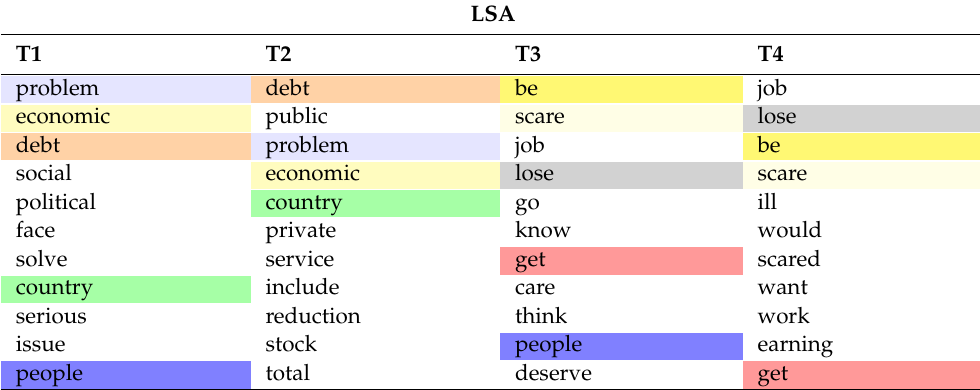
Table 2. Collection of topics and the top 10 keywords of the corresponding topic represented by the LSA